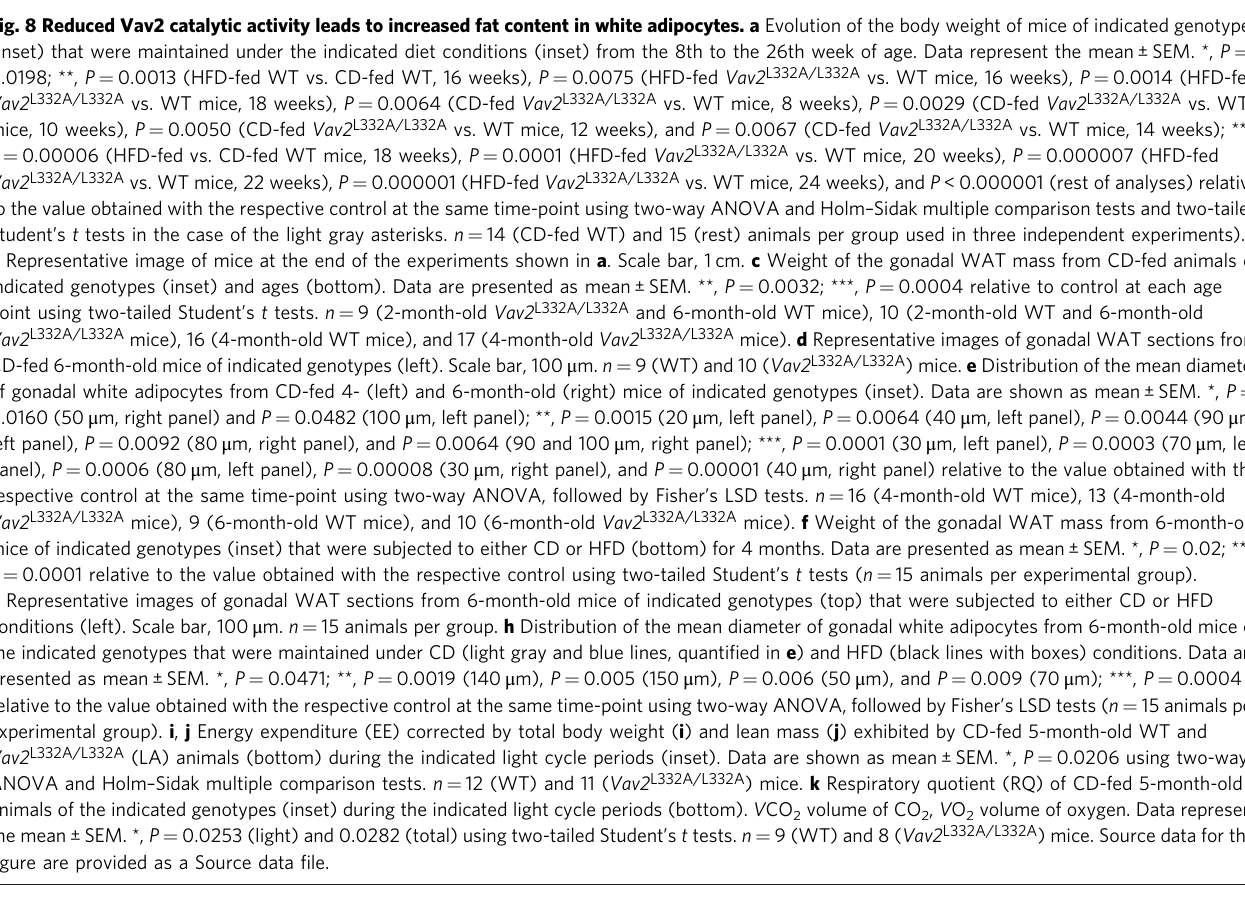
animals of the indicated genotypes (inset) during the indicated light cycle periods (bottom). V CO 2 volume of CO 2 , V O 2 volume of oxygen. Data